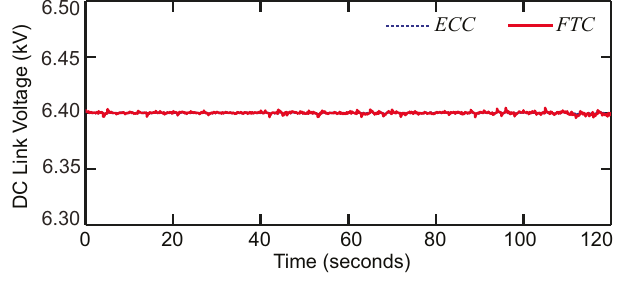
Figure 7. DC-link voltage.